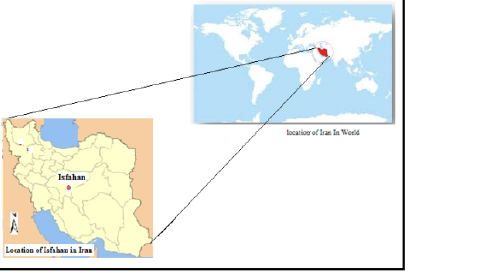
Fig. 1. Location of study area in Iran and